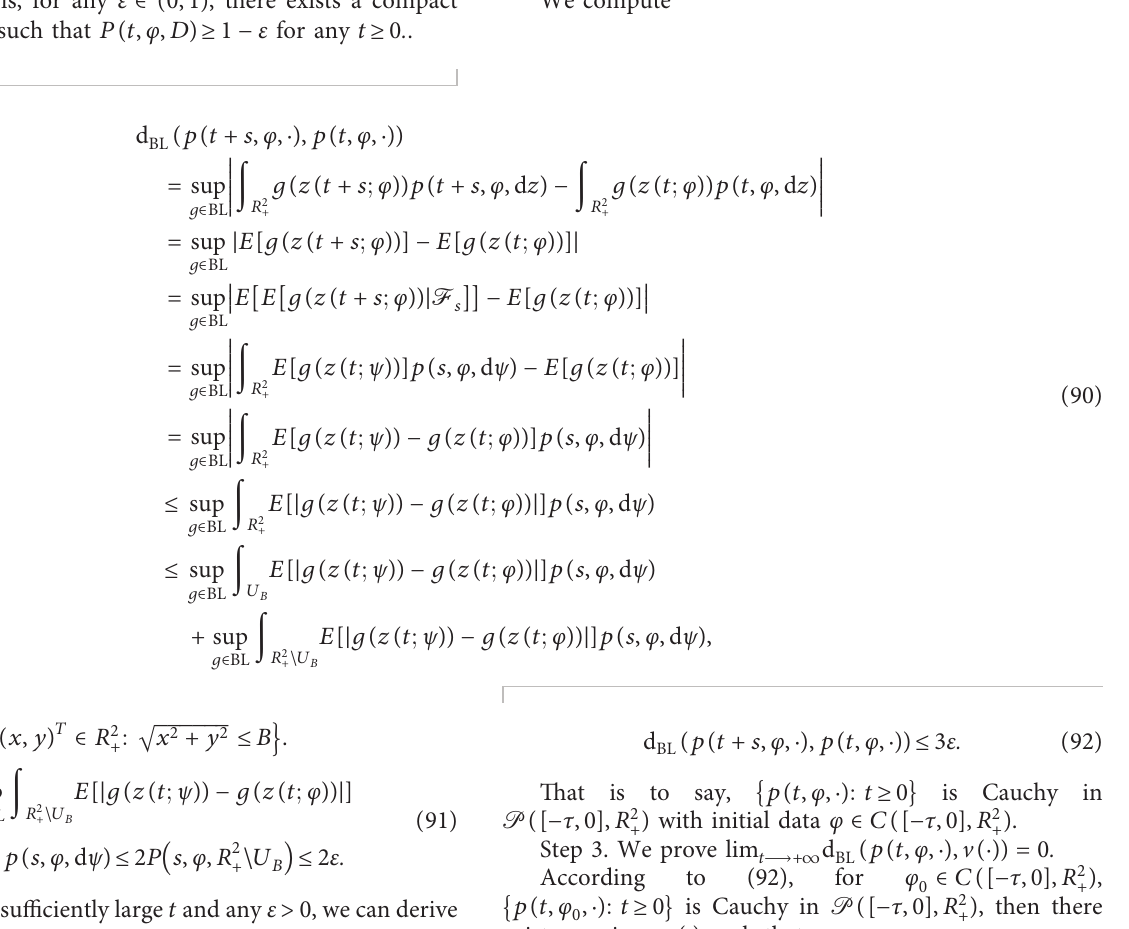
c ( u ) � 1 . 0187 , c 0 ) with 1 ( u ) � 1 . 6876, 2